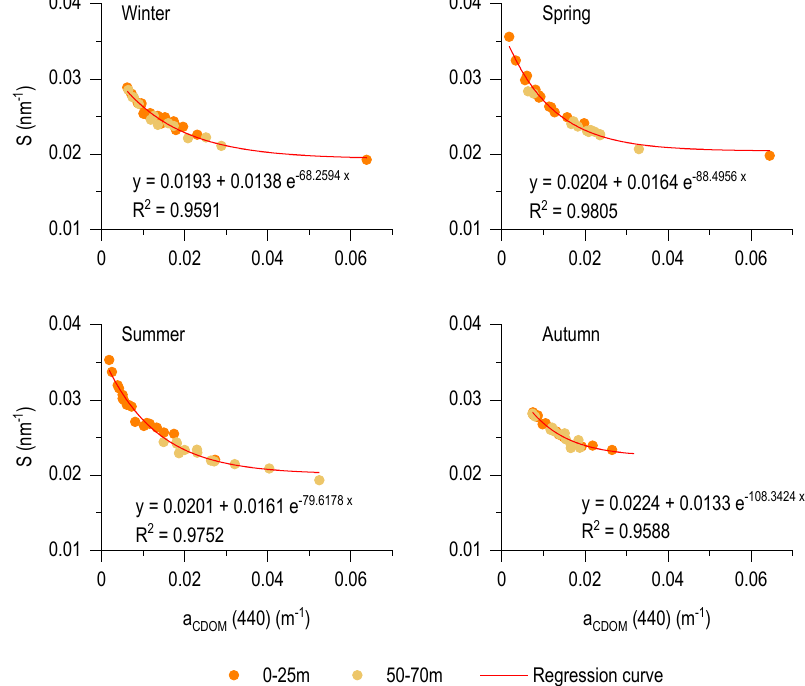
Figure 9. Relationship between S (nm −1 ) and a CDOM (440) (m −1 ).